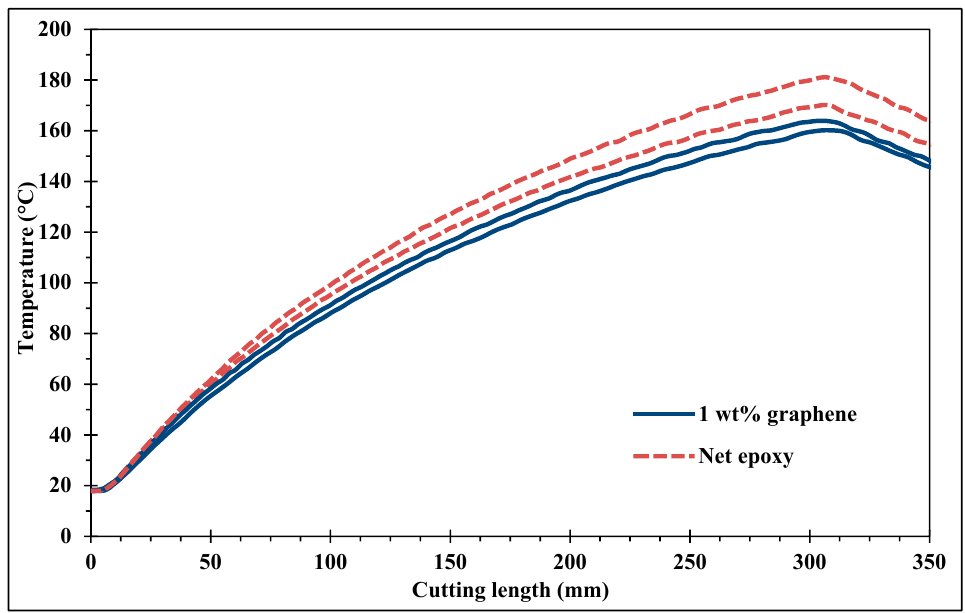
Figure 11. Cutting temperature curves.